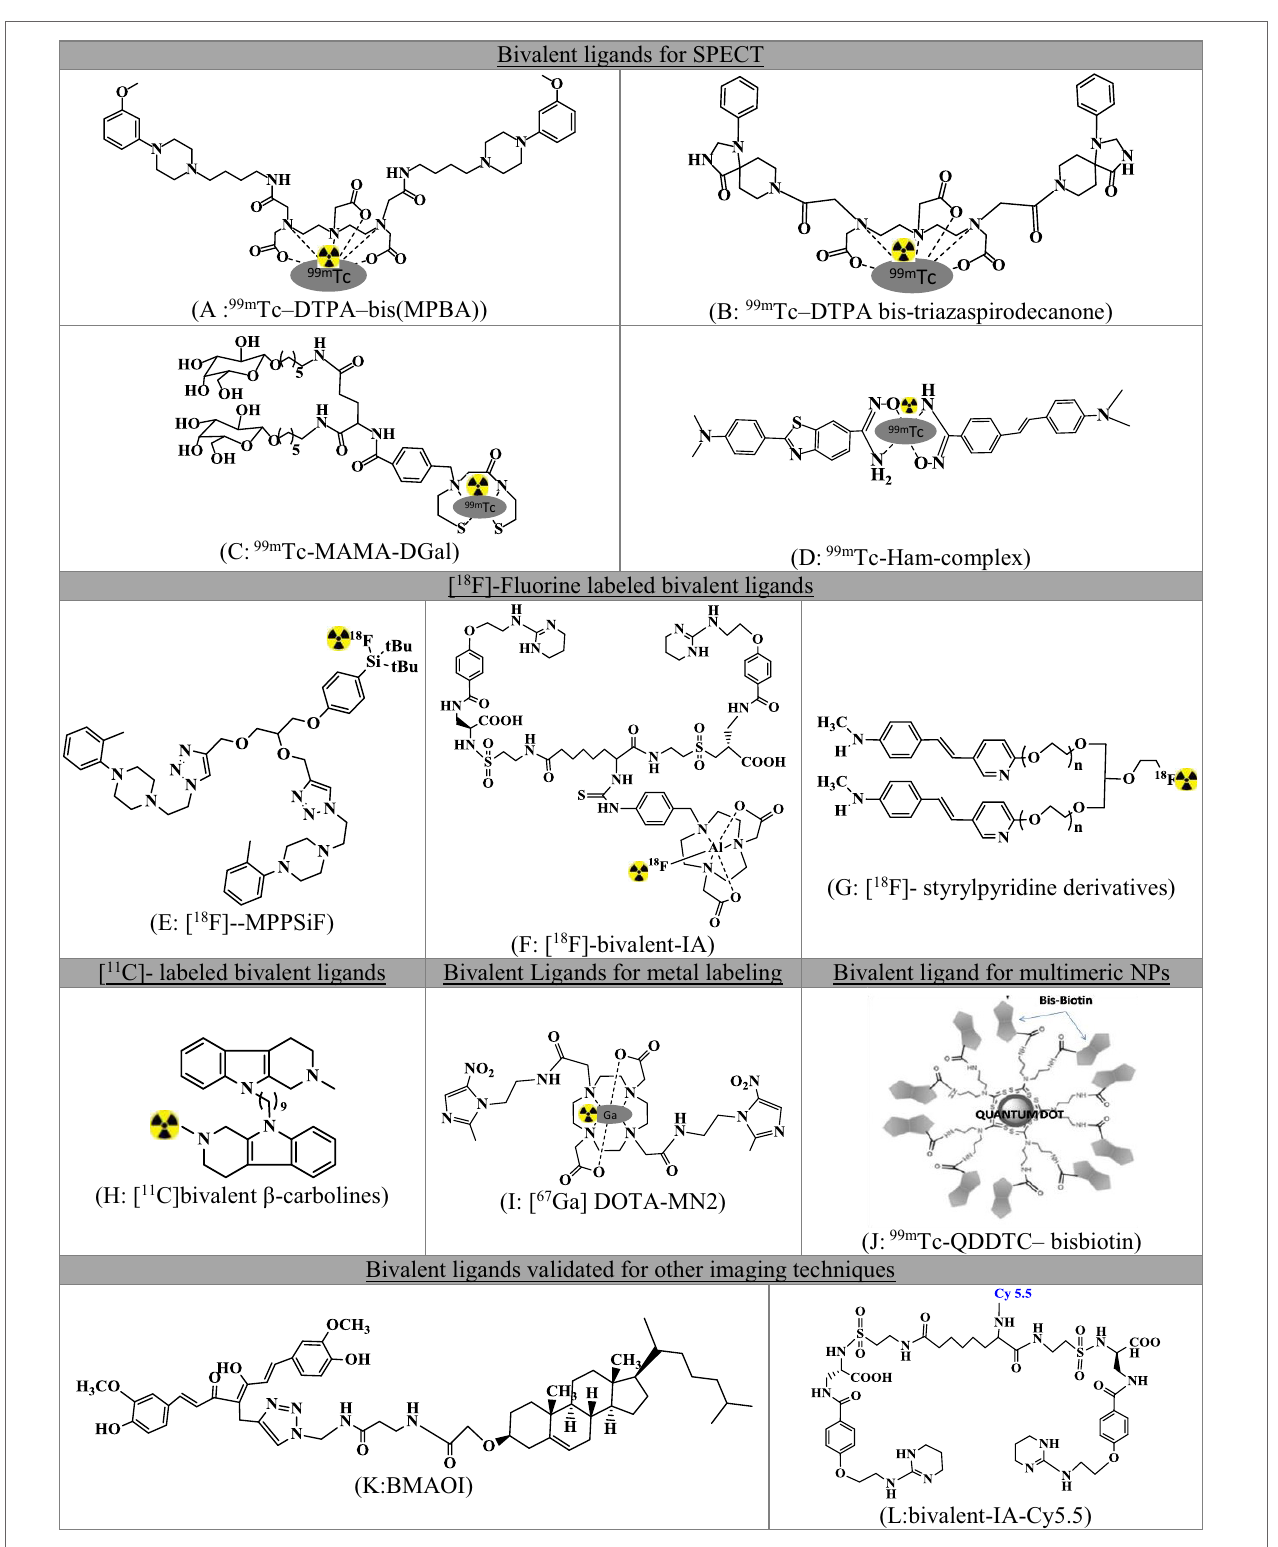
FiGURe 2 | Comprehensive list of small molecule-based bivalent ligands for diagnostics. (A) 99m Tc-DTPA-bis(MPBA), (B) 99m Tc-DTPA bis-triazaspirodecanone, (C) 99m Tc-MAMA-DGal, (D) 99m Tc-Ham, (e) [ 18 F]-MPPSiF, (F) [ 18 F]-bivalent-IA, (G) [ 18 F]-styrylpyridine derivatives, (H) [ 11 C]bivalent β -carbolines, (i) [ 67 Ga]DOTA-MN2, (J) 99m Tc-QDDTC-bisbiotin, (K) BMAOI, and (L)